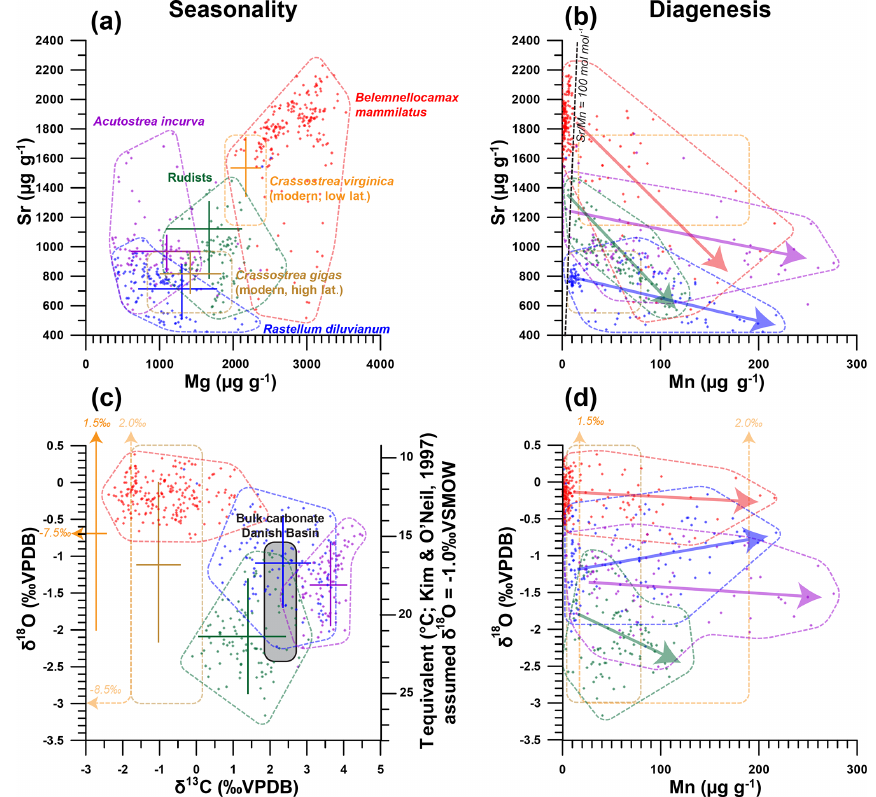
Figure 5. Cross plots summarizing the results of trace element and stable isotope analyses of the oysters R. diluvianum (blue), A. incurva (purple), the rudist Biradiolites suecicus (green) and the belemnite B. mammilatus (red; after Sørensen et al., 2015) from the Kristianstad Basin. Results from modern C. gigas (brown; Ullmann et al., 2013) and C. virginica (yellow; Rucker and Valentine, 1961; Surge et al., 2001) oysters are plotted for comparison. Points indicate individual data points; drawn polygons illustrate the range of the data, and crosses indicate the extent of seasonality (if present). (a) Strontium concentrations plotted against magnesium concentrations. (b) Strontium concentrations plotted against manganese concentrations. Arrows indicate the interpreted direction of diagenetic alteration, and the black dashed line shows the Sr / Mn diagenesis threshold proposed for belemnite rostra by Sørensen et al. (2015; 100molmol − 1 ). (c) δ 18 O plotted against δ 13 C. Grey area indicates the range of stable isotope ratios measured in Campanian chalk deposits from the nearby Danish Basin by Thibault et al. (2016). (d) δ 18 O plotted against manganese concentrations, with arrows indicating proposed direction of diagenetic